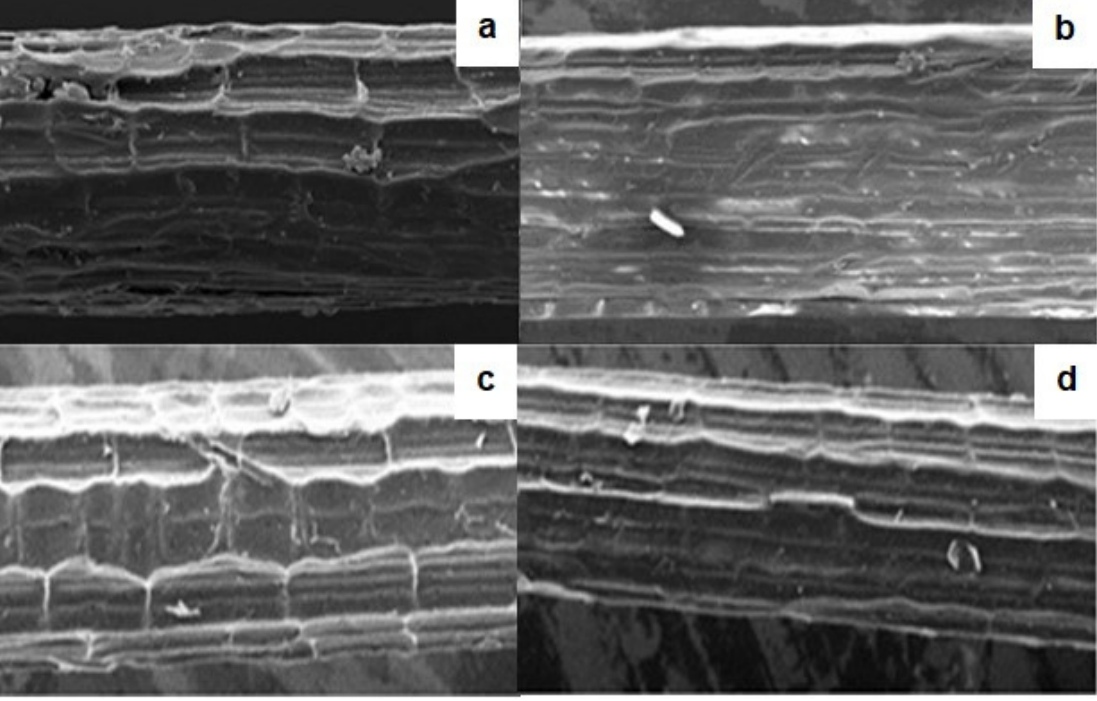
Figure 3. Surface morphology of the fique fiber before and after modification treatments: ( a ) non- modified fiber (Nmf), ( b ) fiber treated with pectinase (Pec), ( c ) fiber treated with xylanase (Xyl). ( d ), and fiber treated with ligninase